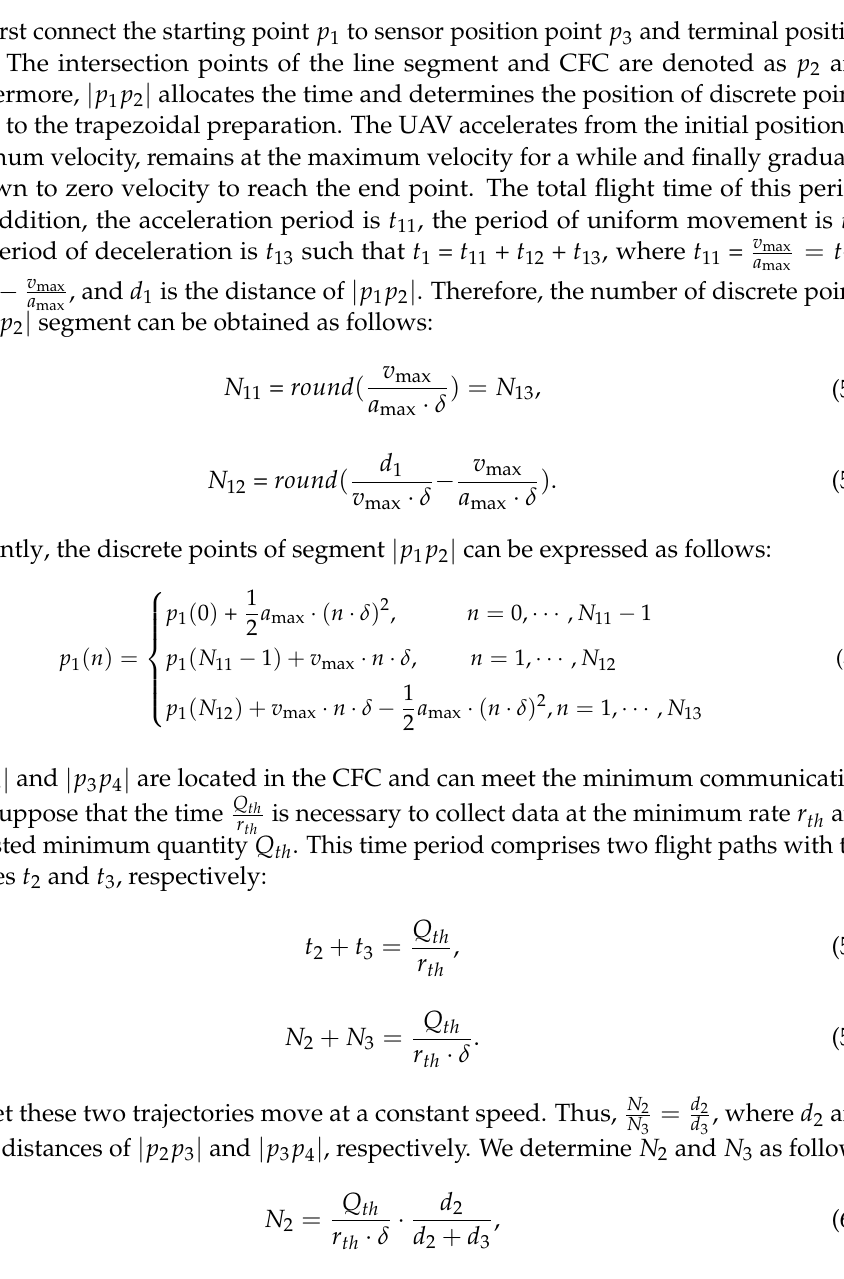
Figure 3. Path initialization based on